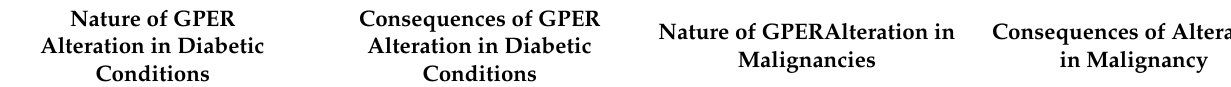
Table 4. Dysregulated GPER expression in DM and